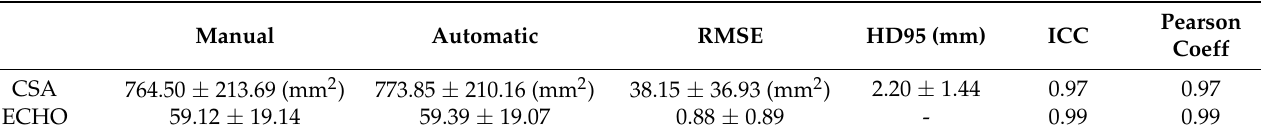
Table 3. Comparison results between the manual and automatic muscle CSA measurements.